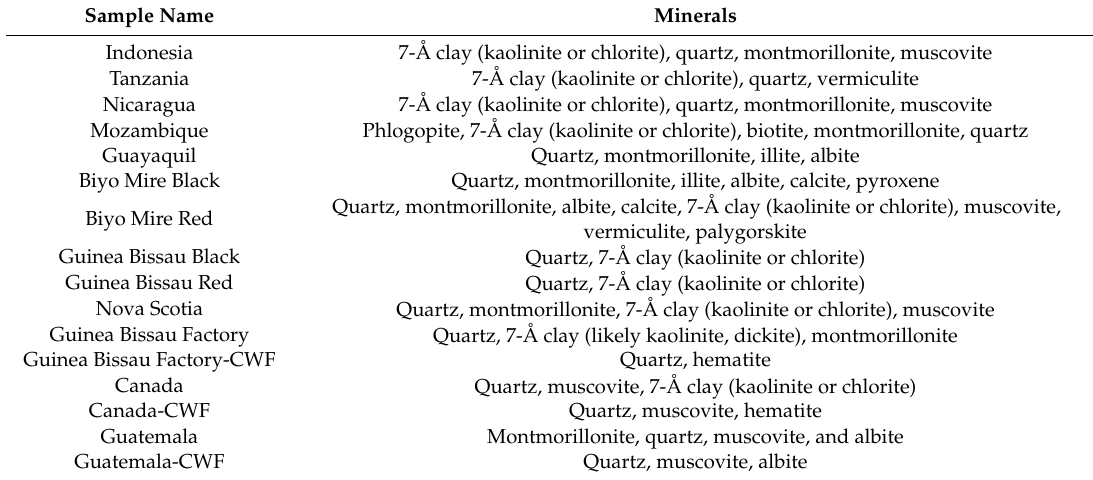
Table 3. Summary of X-ray di ff raction (XRD) spectra collected for CM and ceramic water filter (CWF) samples